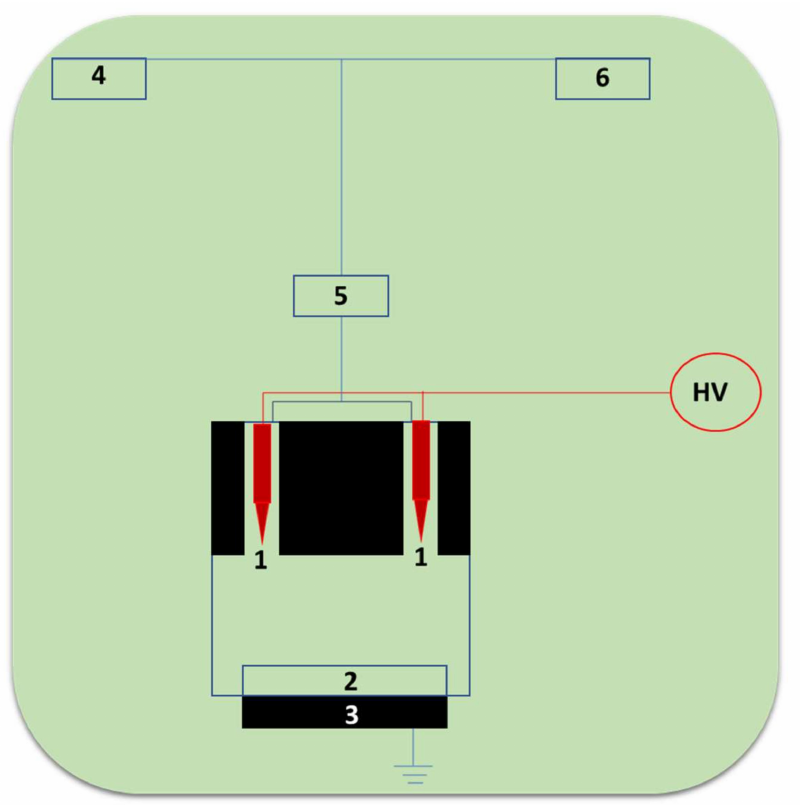
Figure 8. The schematic setup of the SPP apparatus for the biorecognition layer of laccase cross-linking inside of the plasma zone (1-pointed tungsten electrodes, 2-conductive solid support, 3-grounded electrode, 4-laccase enzyme solution, 5-atomizer, 6-helium